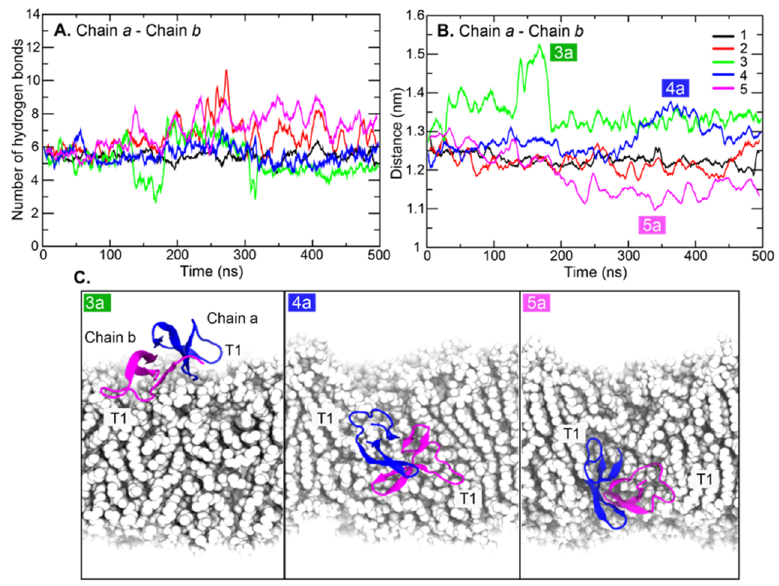
Figure 5. ( A ) Number of hydrogen bonds between chains a and b and ( B ) distance between the center of mass of chain a and chain b as a function of time. ( C ) HD5 orientations at positions 3a, 4a, and 5a. Chains a and b are colored in blue and magenta, respectively. T1 loop regions from each chain are also labeled. Table 2. Free energy of binding of protein and membrane at the five positions. Binding Energy